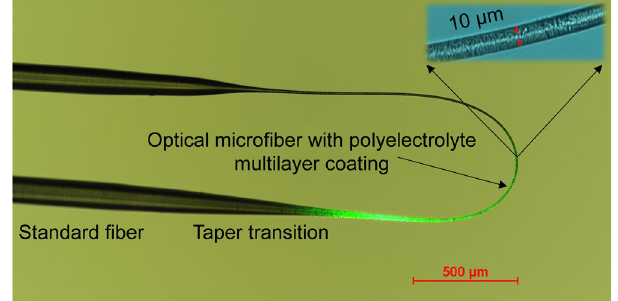
Figure 2. Microscope image of the sensor head, consisting of a U-shaped microfiber functionalized with polyelectrolyte multilayer coating. Green light was launched into one end of the optical microfiber to give an insight into the evanescent field of